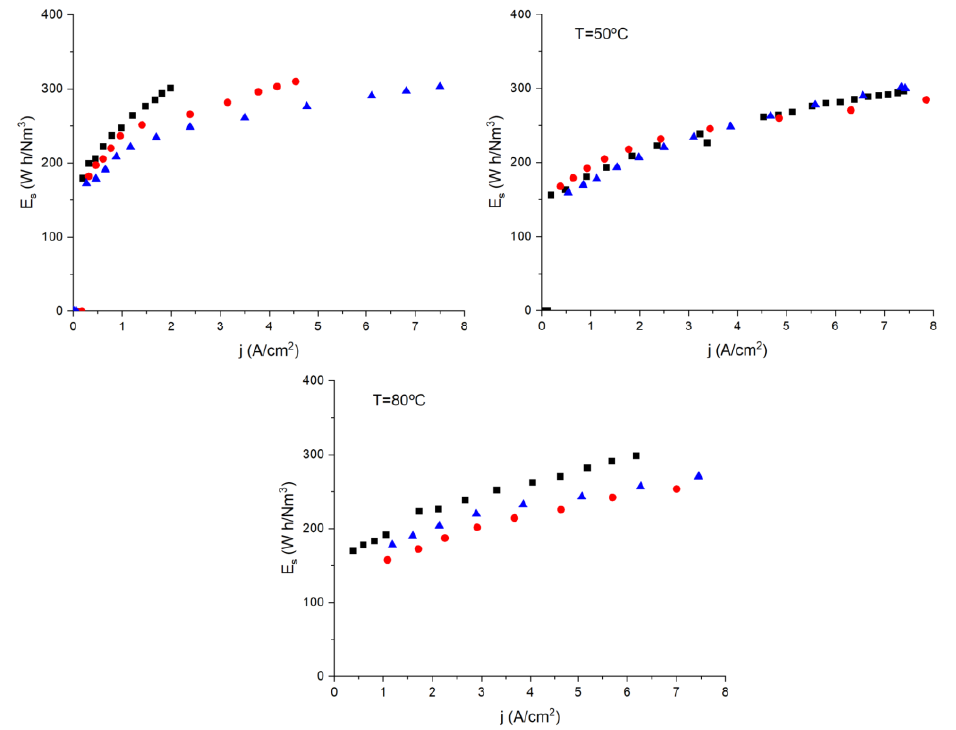
Figure 10. Specific energy consumption required to produce hydrogen by water electrolysis for the different membranes MF-4SC ( ■ ), MF-4SC-PANI* ( ⬤ ), and MF-4SC-PANI** ( ), respectively, at: 30, 50, and 80 °C, respectively.